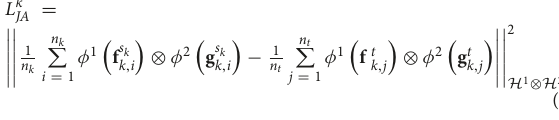
FIGURE2 Flowchart of the acquisition of EEG in one session for one subject.